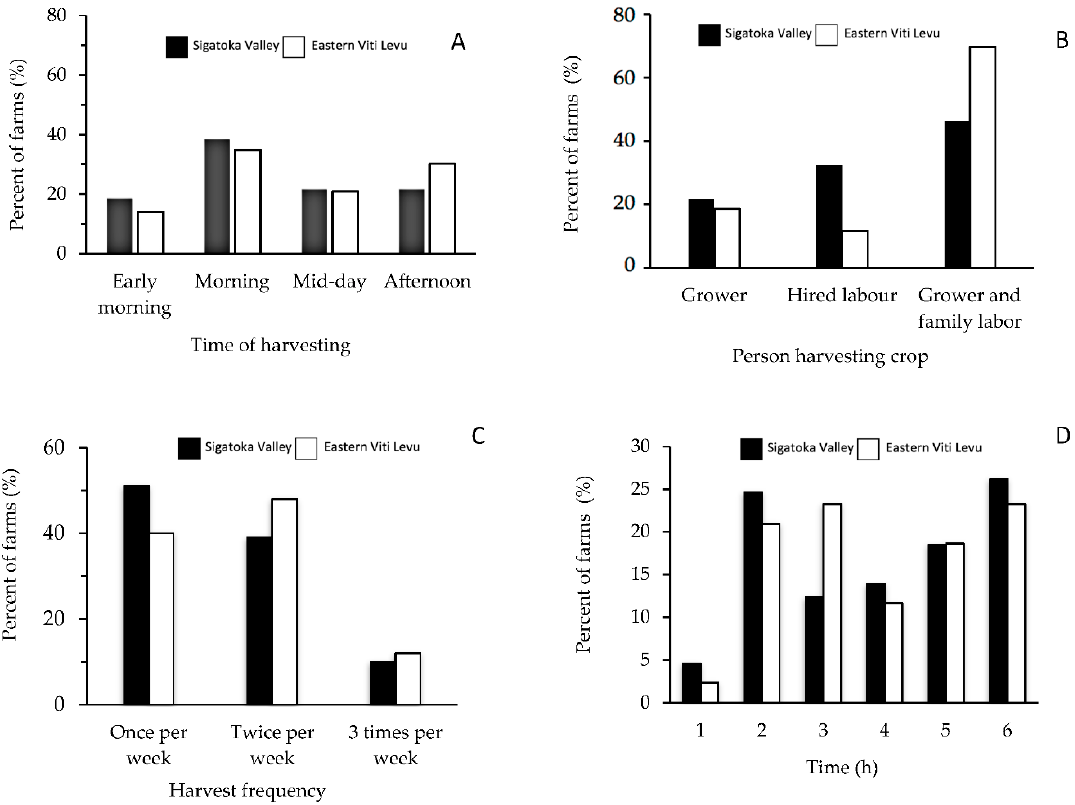
Figure 2. The percentage of Fijian tomato farmers (value chains) in the Sigatoka Valley and Eastern Viti Levu, according to specific harvesting practices used. ( A ) Time of day that the crop was harvested. ( B ) The person who undertook the harvesting of the crop. ( C ) The frequency the crop was harvested per week. ( D ) The time between when the product (tomato) was harvested and when it arrived at the on-farm packing site (i.e., the delay in transporting the product from field to the farm packing shed or similar on-farm infrastructure to be ripened).